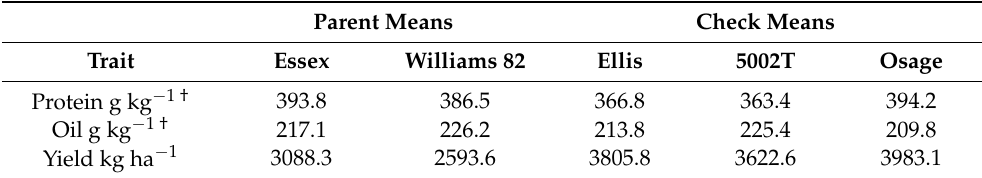
Table 1. Means of protein, oil and yield of soybean seed for parents and checks grown in Knoxville, TN; Springfield, TN; and Milan, TN. Parent Means